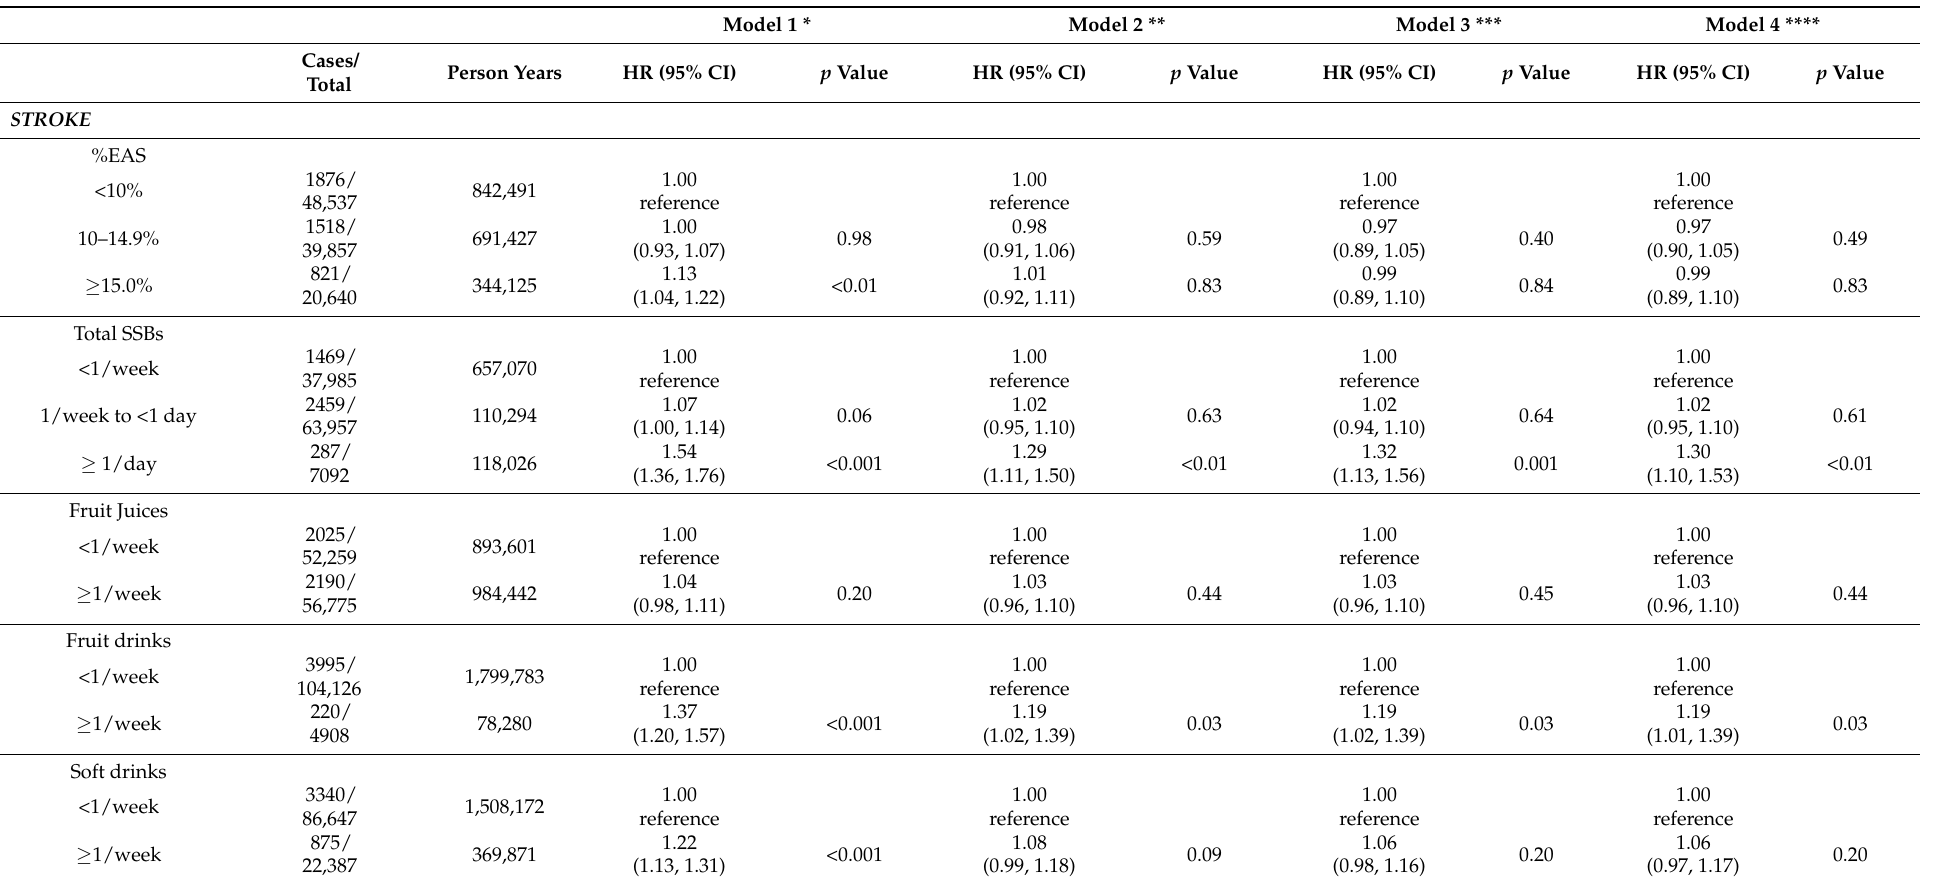
Table 3. Prospective association of added sugars and SSBs with stroke and stroke subtypes among 109,034 participants in the Women’s Health Initiative (CT + OS)